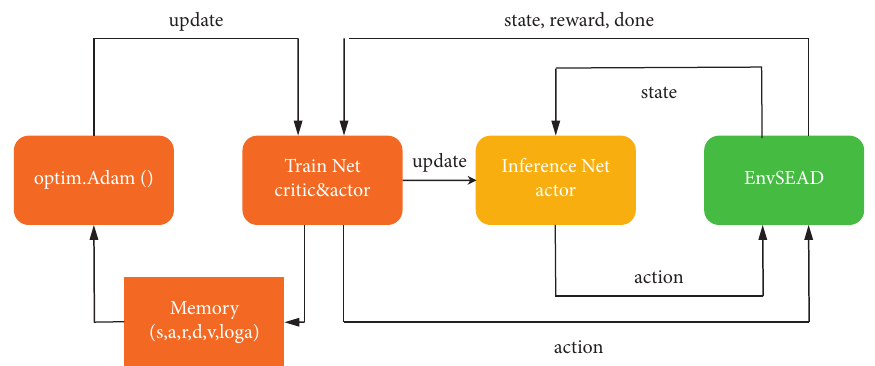
Figure 5: Research framework used in the present